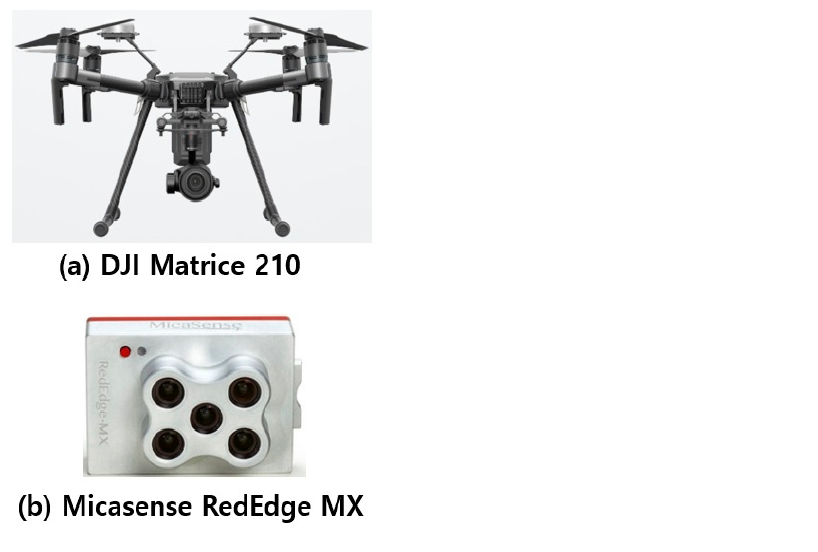
Figure 4. UAV flight planning using the DJI GS Pro S/W. Table 1. Specifications of the Micasense RedEdge MX. Items